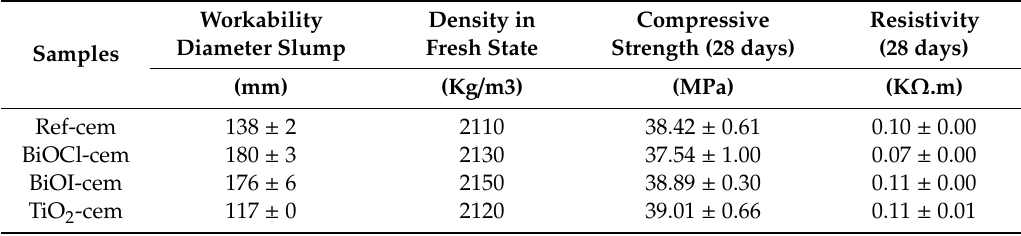
Table 1. Fresh, mechanical and electric resistivity properties of tested